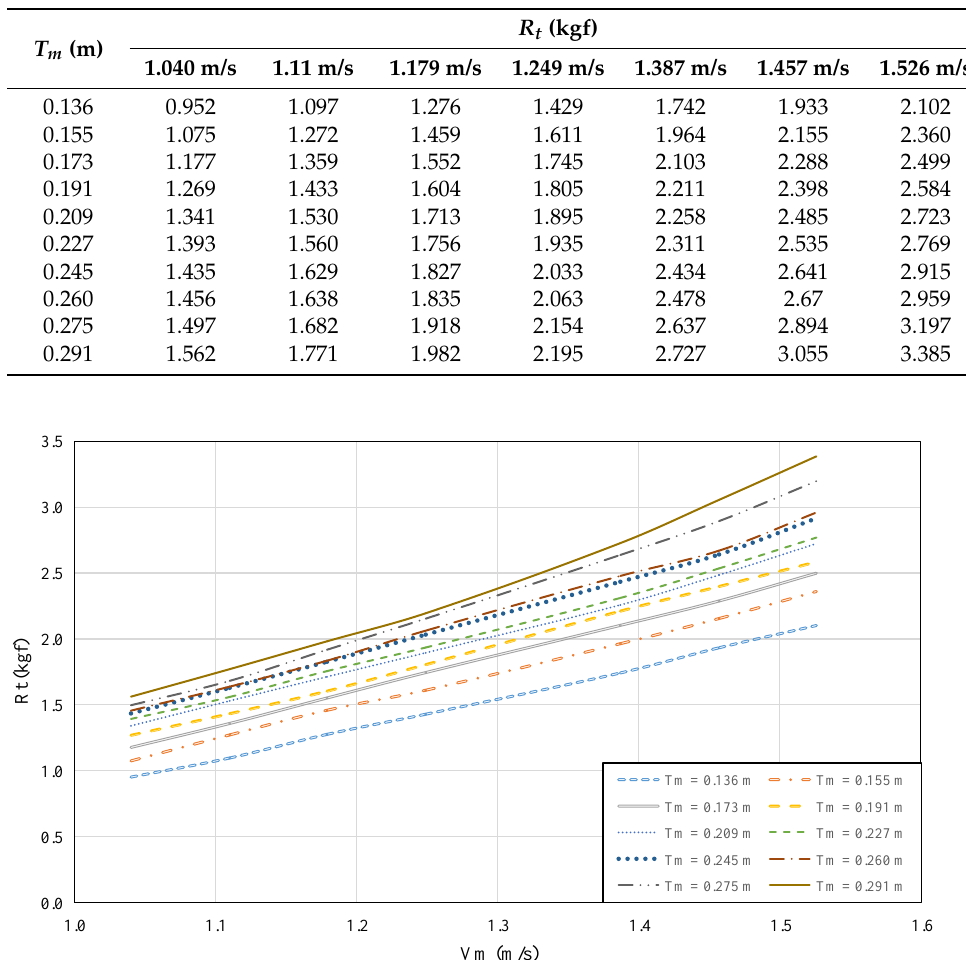
Figure 3. The model ship resistance changes with velocities at different drafts. Table 4. Model ship resistance at different speeds and drafts.